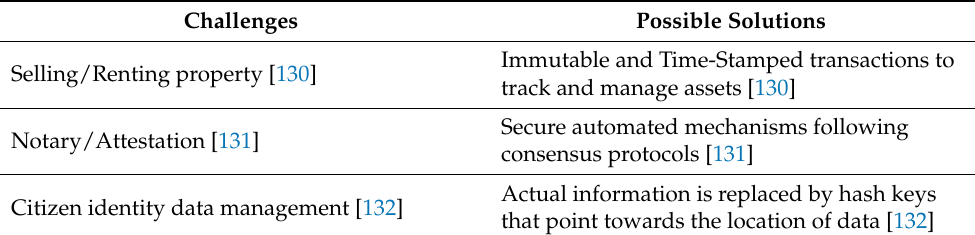
Table 4. Blockchain for